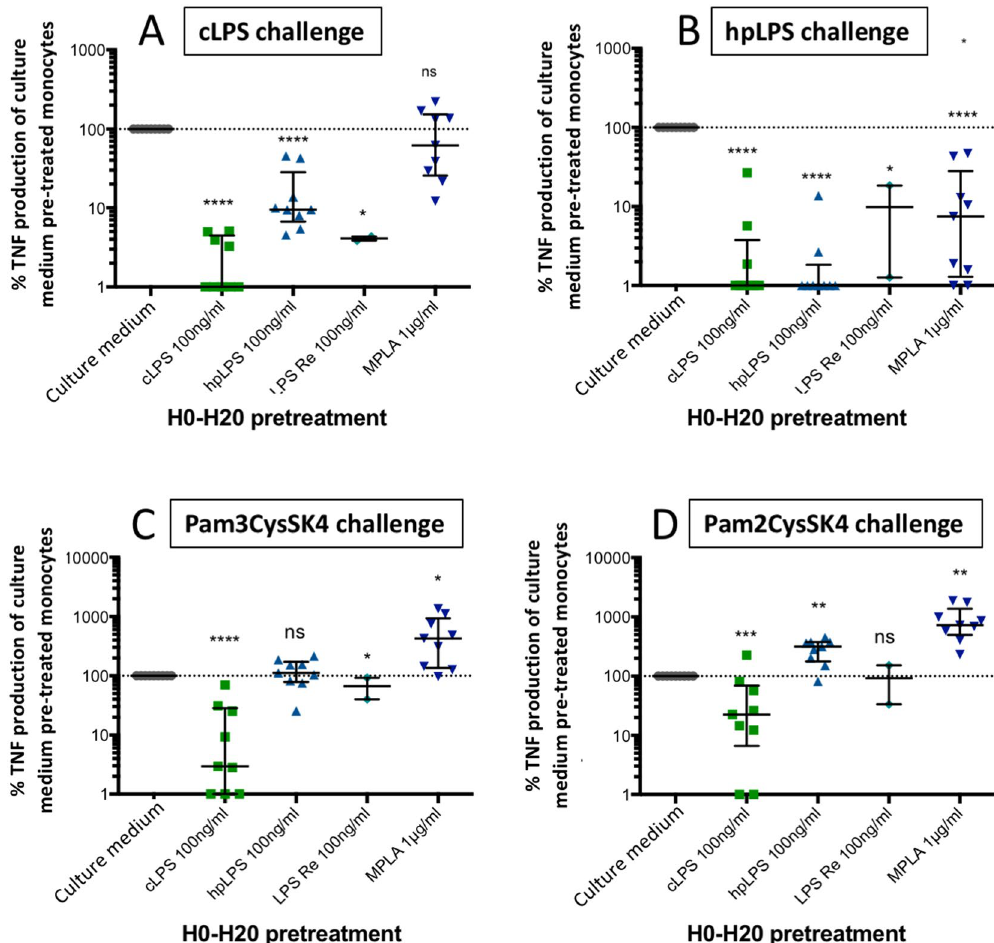
Figure 8. Induction of homo- and cross-tolerance. Human adherent mononuclear cells were pretreated for 20 h with either conventional smooth E. coli O111:B4 LPS (cLPS) (100 ng/ml), highly purified S. abortus equi LPS (hpLPS) (100 ng/ml), highly purified rough S. minnesota R595 LPS (ReLPS) (100 ng/ml) or MPLA (1 µ g/ ml). After elimination of the supernatants and washings, cells were re-challenge with either cLPS ( A ), hpLPS ( B ), Pam 3 CysSK 4 ( C ) or Pam 2 CysSK 4 ( D ), and TNF production was assessed 20 h later. The results are expressed as percent of the production of individual donors to the different agonists used for challenge in cells, which had not been pre-treated with TLR agonists. Each dot represents individual donors. * p ≤ 0.5; ** p < 0.01; *** p < 0.001; **** p <